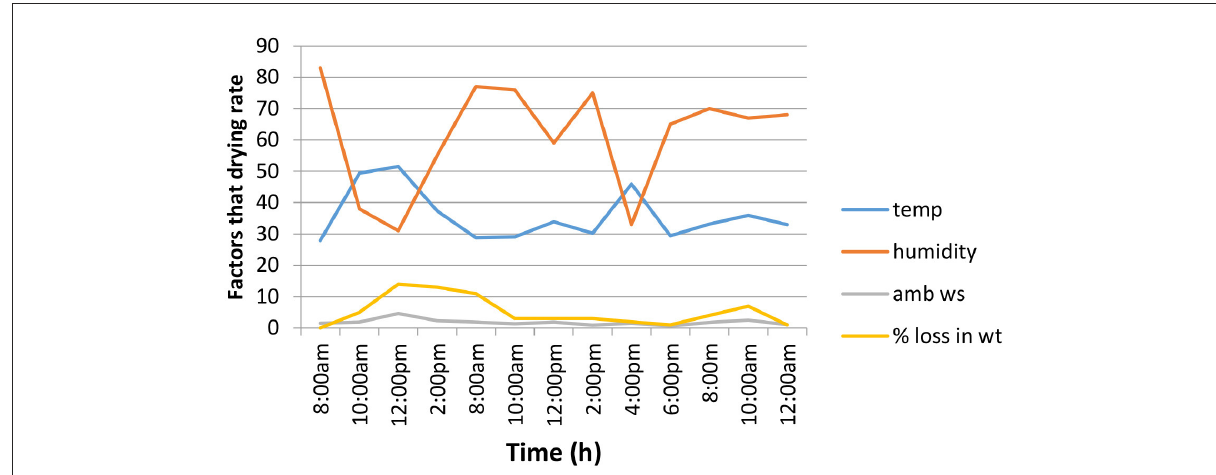
FIGURE5 Changes during the solar drying of fermented cocoa beans. Temp, temperature ( o C); Ambws, ambient wind speed (m/s); % loss in wt, % loss in weight; humidity (g/m 3 ).